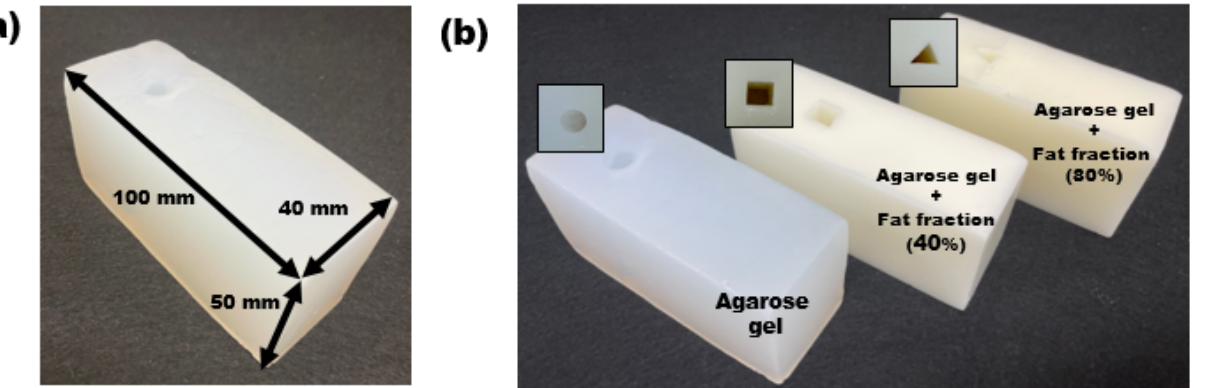
Figure 1. ( a ) Brick-type gel phantom (dimensions: 100 mm × 40 mm × 50 mm), ( b ) emulsion phantom based on agarose containing fat fractions of 40% and 80%. A circular, rectangular, and triangle hole was drilled in the respective phantoms (the circular hole indicates agarose gel, the rectangular hole indicates 40% fat fraction gel, and the triangular hole denotes 80% fat fraction gel).